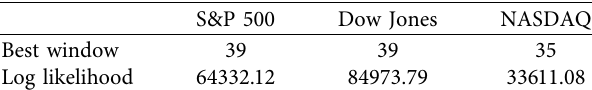
Table 4: Best window length of the simple